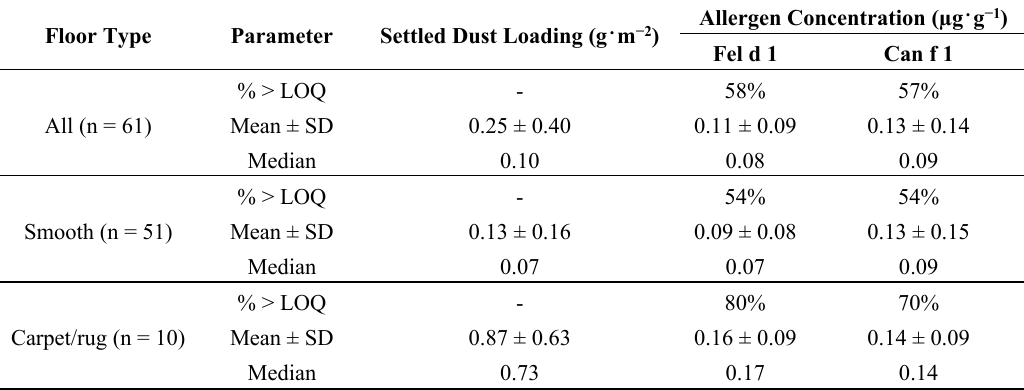
Table 3. Pet allergen concentrations in the settled dust vacuumed from